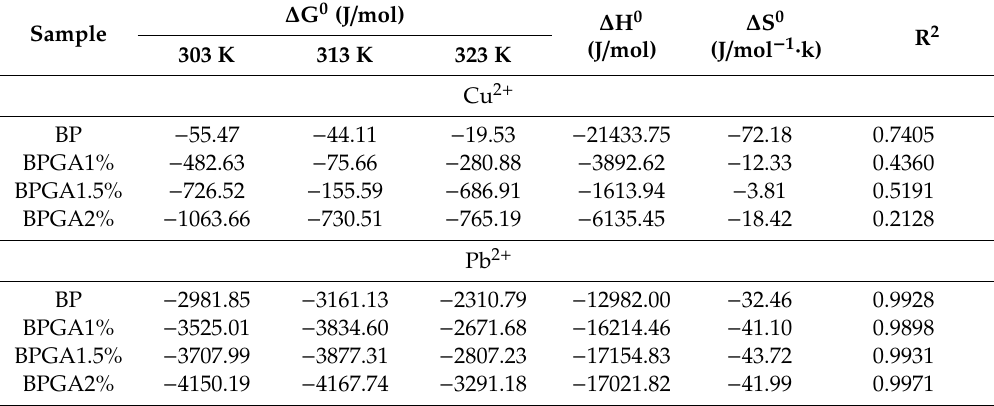
Table 5. Thermodynamic Parameters: change in Gibbs energy ( ∆ G 0 ), in enthalpy ( ∆ H 0 ), and in entropy ( ∆ S 0 ) for Cu 2 + and Pb 2 + for temperatures between 303 K and 323 K.